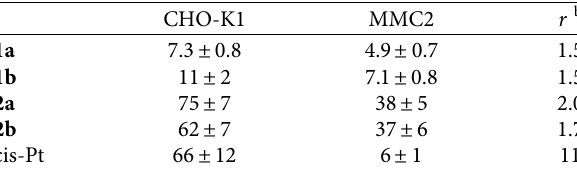
a The results are expressed as mean values ± SD from three independent experiments, each performed in duplicate. b r � a ratio defined as IC 50 (NER- efficient, CHOK-1)/IC 50 (NER-deficient,